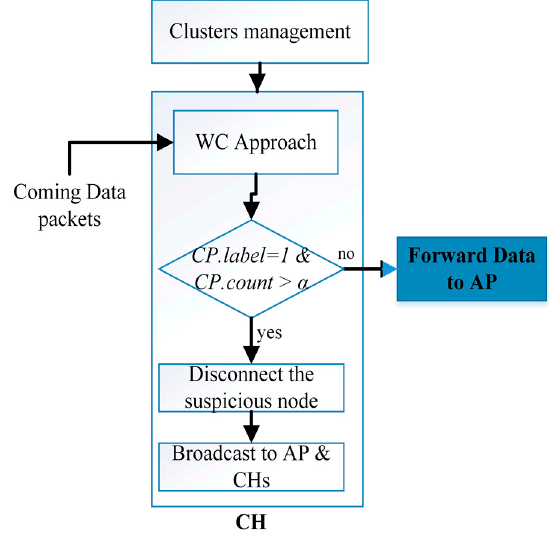
Figure 4. Decision making process in each